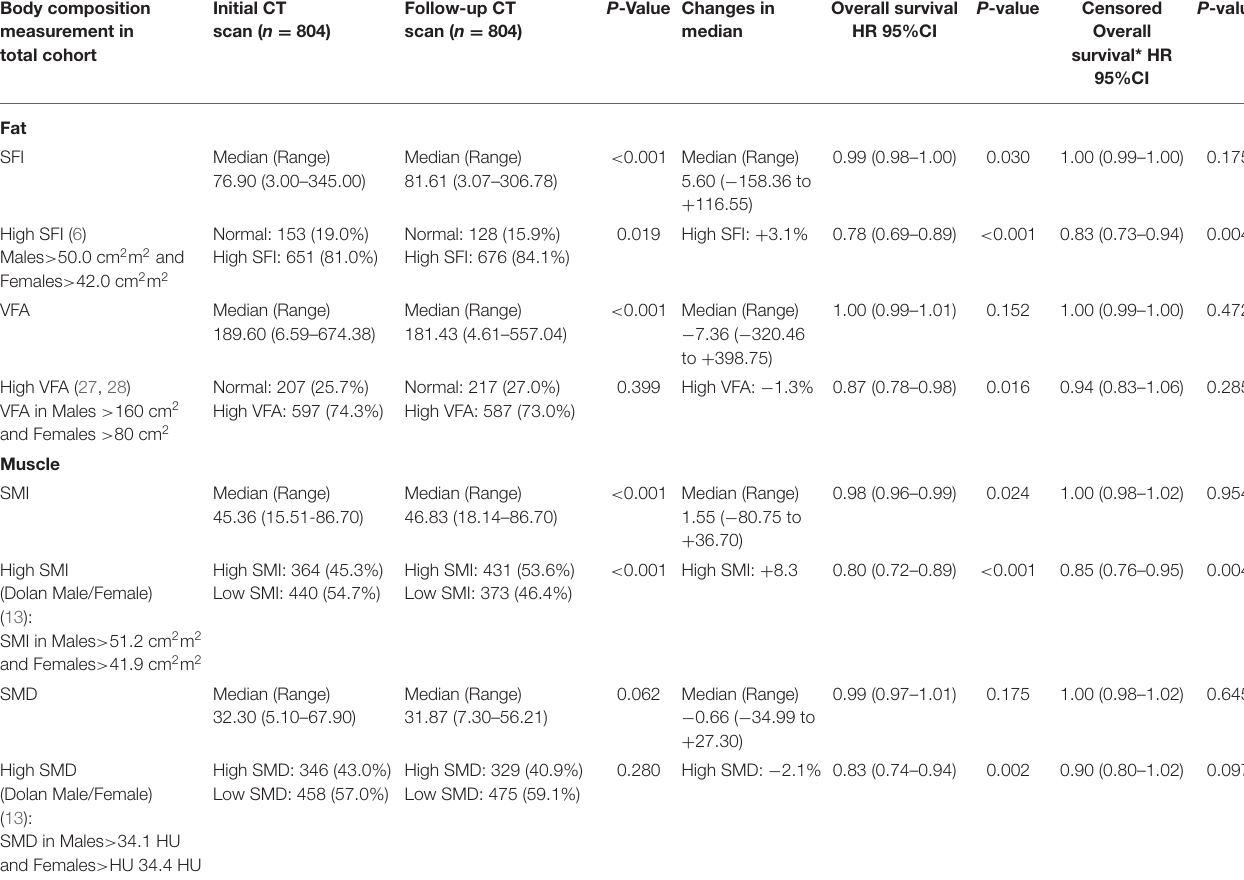
TABLE 2 | The longitudinal changes in CT-derived body composition measures in patients undergoing surgery for colorectal cancer. Body composition measurement in